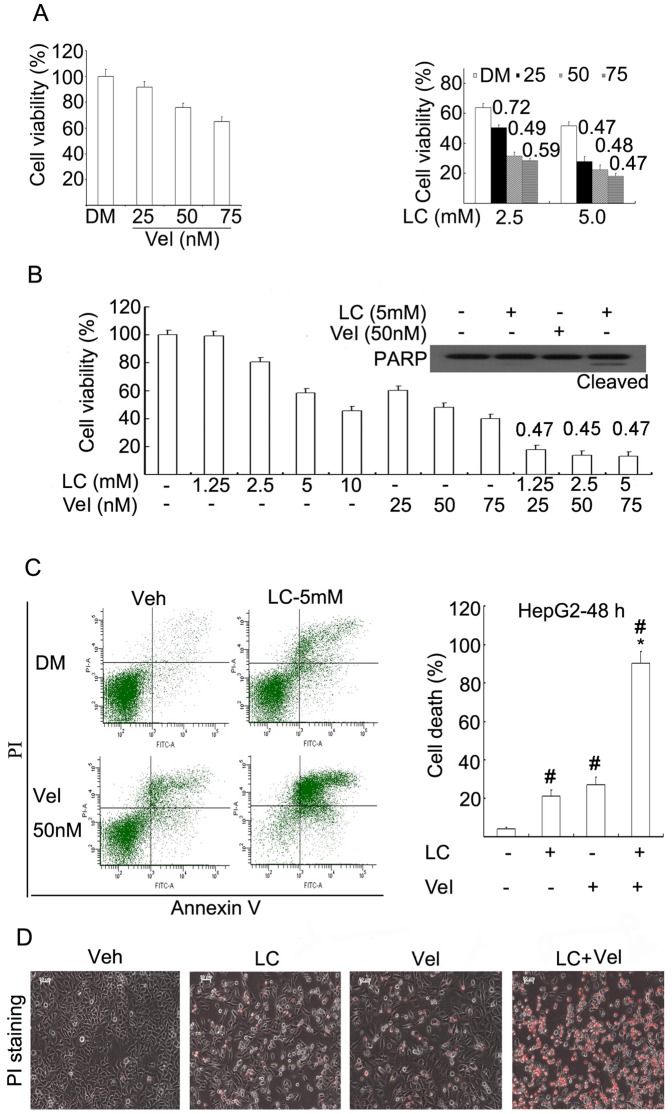
Proteasome inhibitor Vel and LC synergistically induce cancer cell proliferation arrest and cell death in vitro.(A) HepG2 cells were treated with various doses of Vel as indicated in the presence (2.5, 5.0 mM) or the absence of LC for 24 h, cell viability was detected by MTS assay. Mean+SD (n = 3). Combination index (CI) was shown. Vel: bortezomib; DM: DMSO; LC: L-carnitine. (B) Human hepatic SMMC-7721 cancer cells were treated with LC and/or Vel for 48 h, cell viability was detected by MTS assay and PARP cleavage was detected by Western blot. CI was shown. (C) HepG2 cells were treated with the combination of Vel (50 nM) and LC (5 mM) for 48 h and cell apoptosis was labeled with Annexin V and propidium iodide (PI), and detected by flow cytometry. Representative flow images were shown and cell death data was summarized. Mean+SD (n = 3). *P<0.05, compared with Vel or LC treatment alone; #P<0.05, compared with Veh control. (D) as treated in C, living cells were directly stained with PI and imaged under an inverted fluorescent miscoscope. The phase contrast and fluorescent images were taken and merged. Red indicates PI-positive. Typical images were shown.